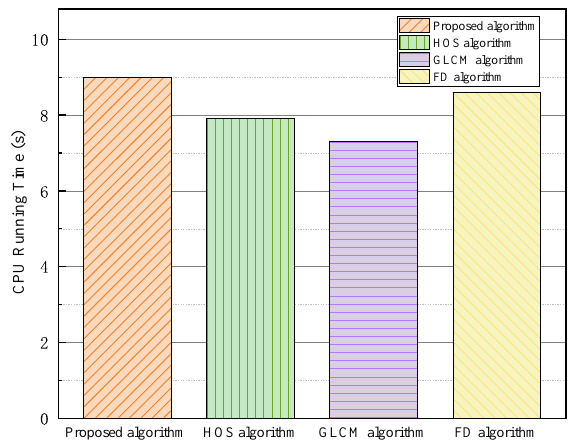
Figure 9. Comparison of CPU running time of different algorithms for extracting constellation diagram